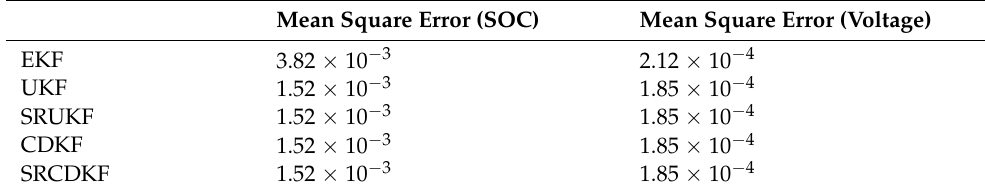
Figure 14. SOC estimated error of model 2 for EKF, UKF, SRUKF, CDKF, and SRCDKF.